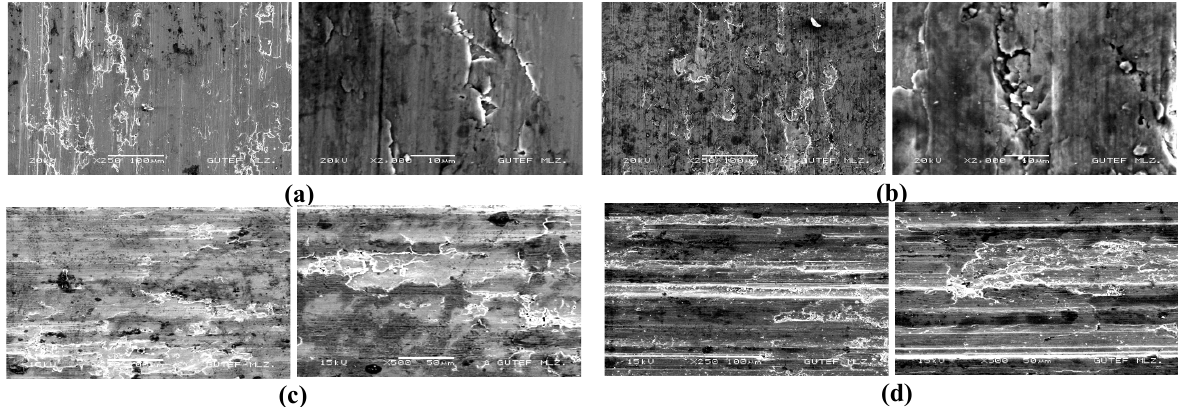
Figure 12. Low ( (cid:2) 250 ) and high ( (cid:2) 2000 ) magnification SEM micrographs of the brasses, which are worn at the 600 m sliding distance, under the 40 N load and at a linear sliding speed of 0.5 m s (cid:3) 1 on the various ductile iron disc. (a) and (b) pearlitic disc, (c) and (d) ferritic